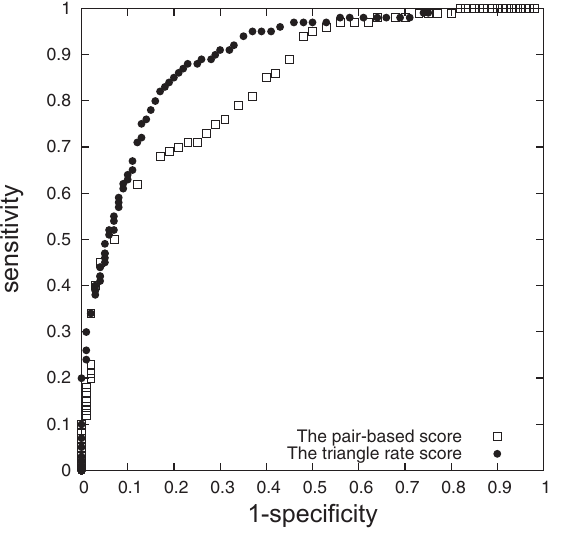
Figure 6. Percentages of Predictions of Interactions Overlap- ping with DIP CORE. For each triangle rate score, the amount of overlap of predicted interactions (score $ this rate) with DIP CORE is